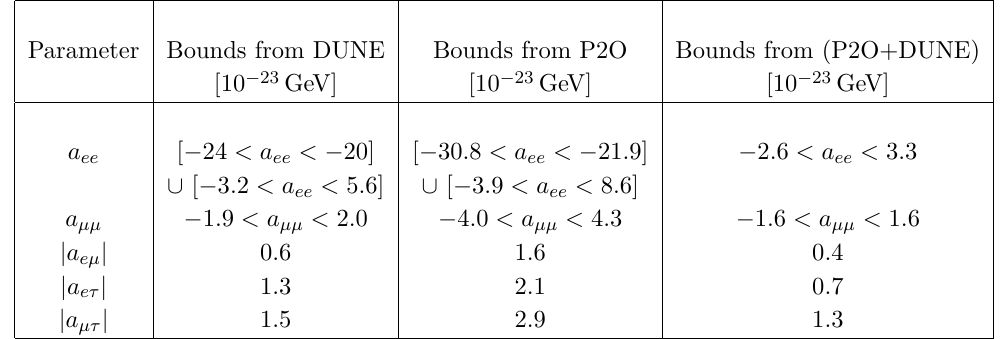
Table 3 . Bounds on the LIV parameters as obtained from the simulations of LBL data: (DUNE, P2O and (P2O+DUNE) in the 2nd, third, fourth column respectively) at 95%